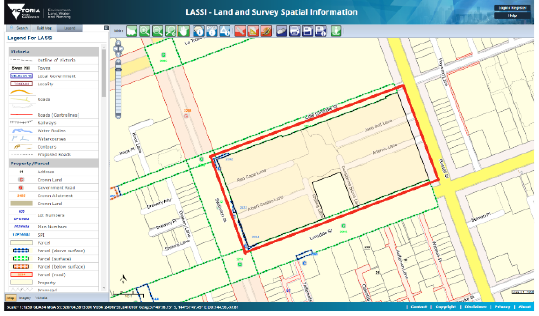
Figure 3. multi storey building shown in LASSI application Since 2014, various technical areas have been investigated as part of the Victorian 3D Digital Cadastre. The technical aspect looks at 3D visualisation, validation and modelling to support building subdivision plans in Victoria. This section provides an overview of current